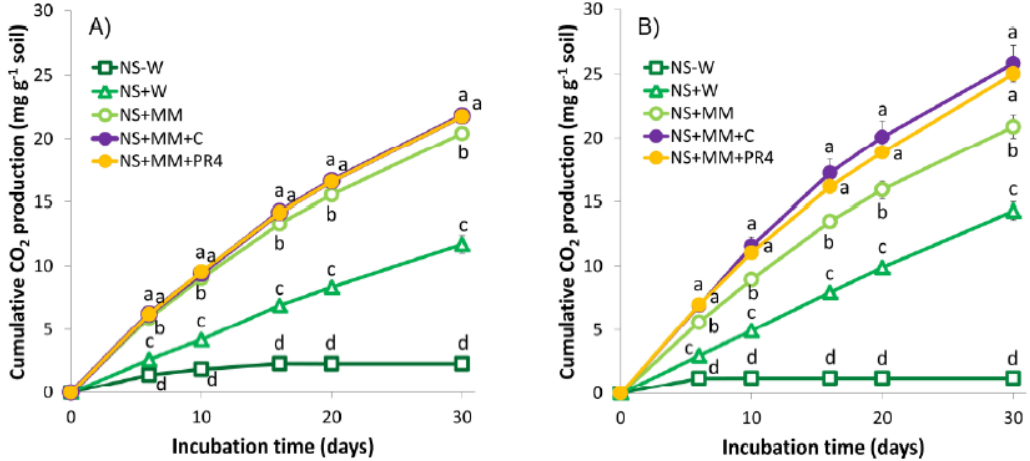
Figure 3. Cumulative CO 2 production in soil microcosms over 30 days, when applying a ( A ) smaller and a ( B ) larger size of inoculum for bioaugmentation. Different letters in the same remediation time indicate statistical differences among treatments ( n = 3, p ≤ 0.05).